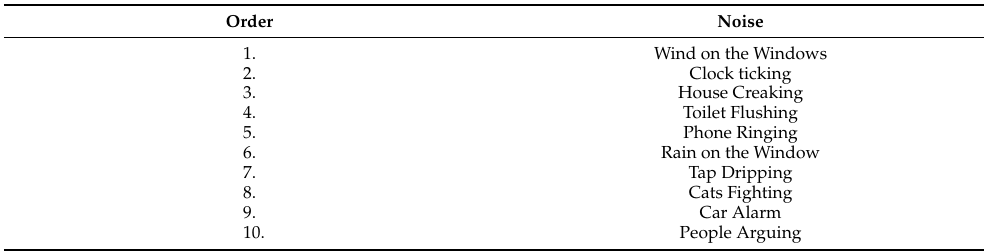
Table 1. Noise stimuli administered to participants (listed in playlist